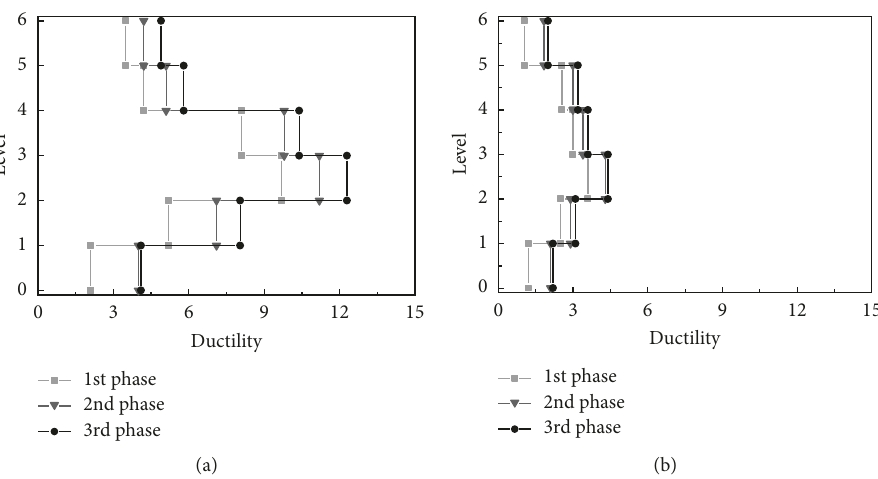
Figure 6: Ductility distribution of HPBRBs along the building height: (a) near-fault condition; (b) far-fault condition.